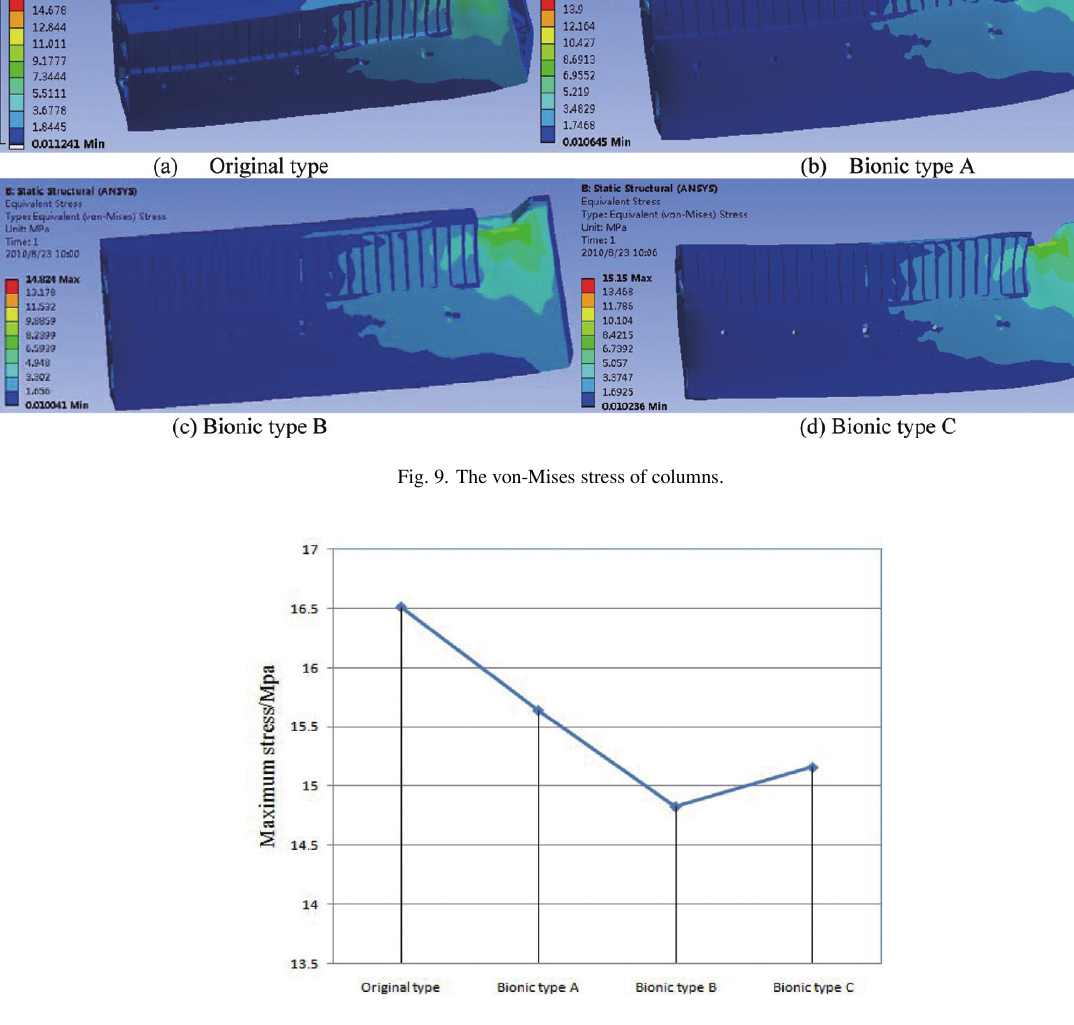
Fig. 10. The maximum stress